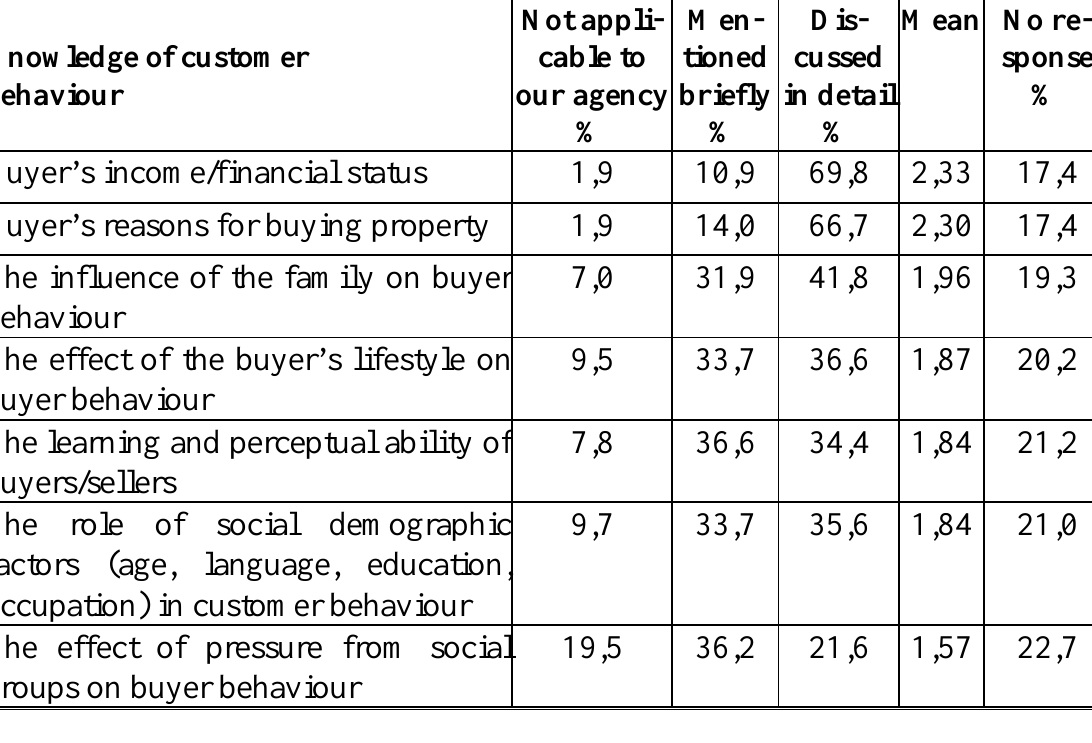
Table 3 Customer behaviour factors covered in training